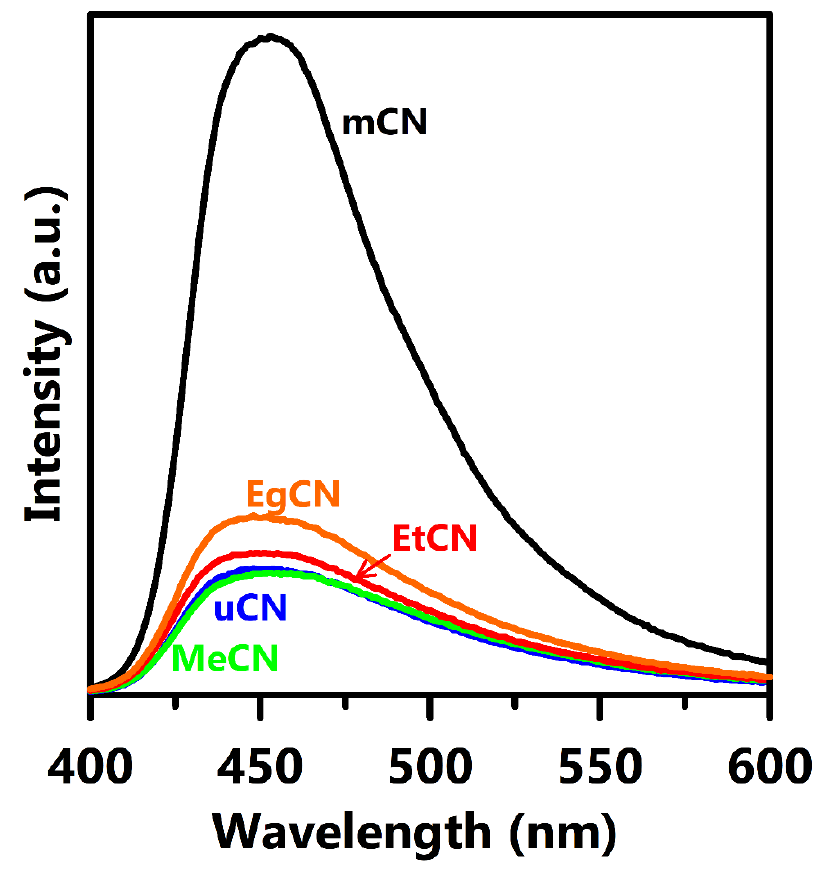
Figure 6. Photoluminescence spectra of mCN, uCN, MeCN, EtCN, and EgCN samples excited at wavelength of 360 nm at room